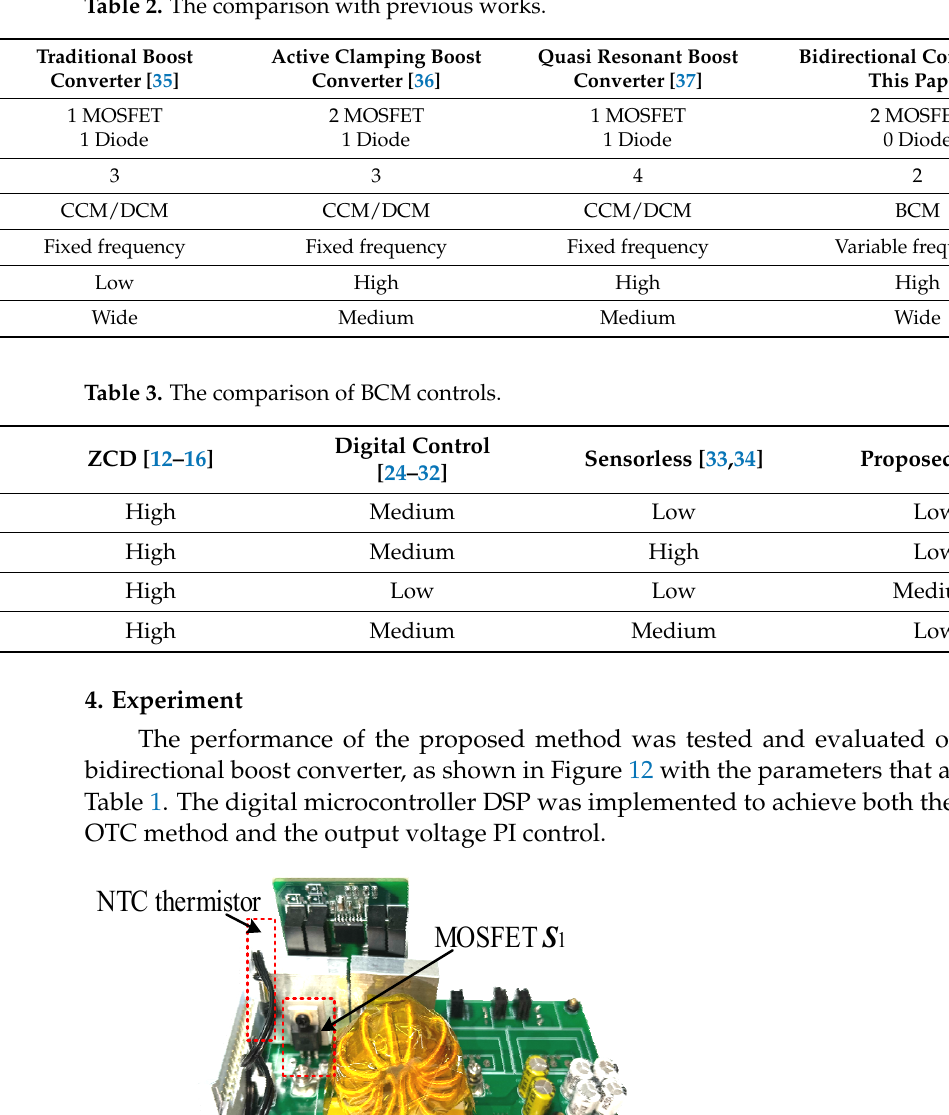
Table 2. The comparison with previous works.